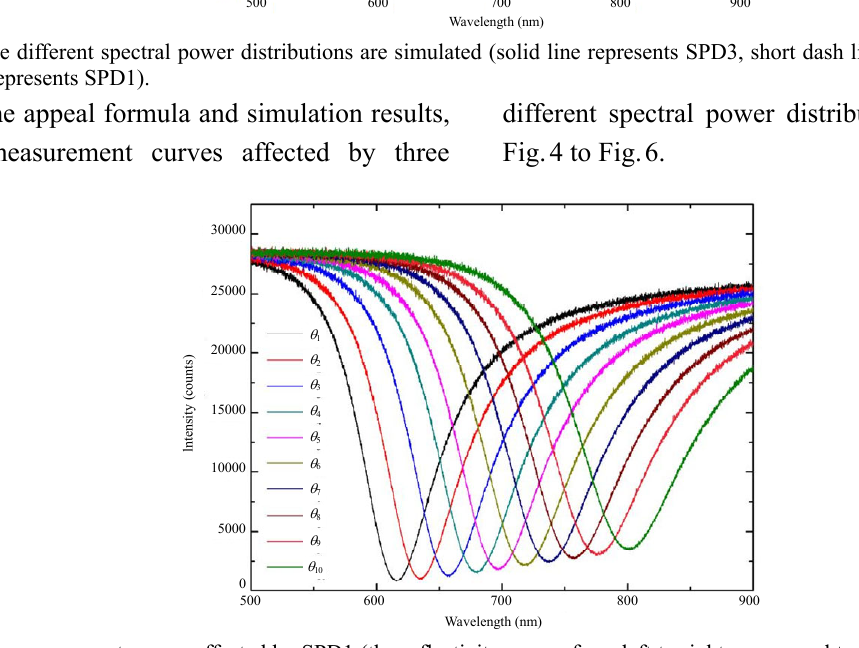
Fig. 4 SPR measurement curves affected by SPD1 (the reflectivity curves from left to right correspond to incident angles θ 1 , θ 2 , θ 3 , θ 4 , θ 5 , θ 6 , θ 7 , θ 8 , θ 9 , and θ 10 ,